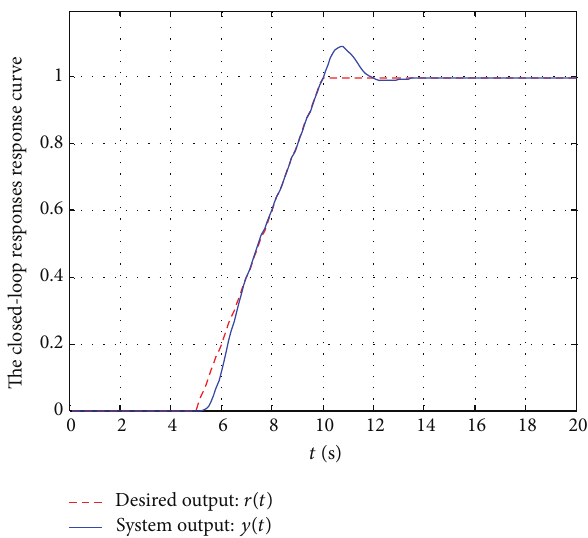
Figure 1: Closed-loop responses of system (33) without preview